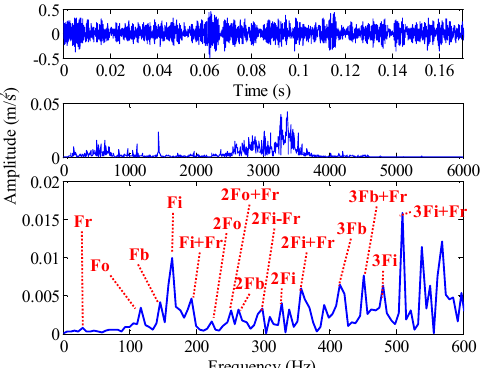
the roller rotates once to produce two shocks. Therefore, the roller failure frequency is easily submerged by the inner ring frequency, outer ring frequency and other components.